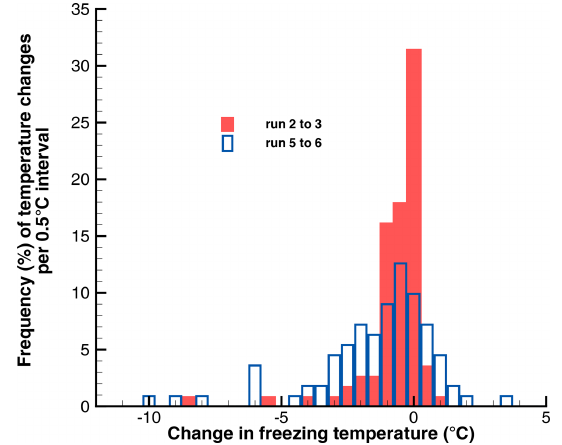
Figure 8. Histograms of the changes in the freezing temperatures of drops between runs with 1 and 5min at T w = + 1 . 5 ◦